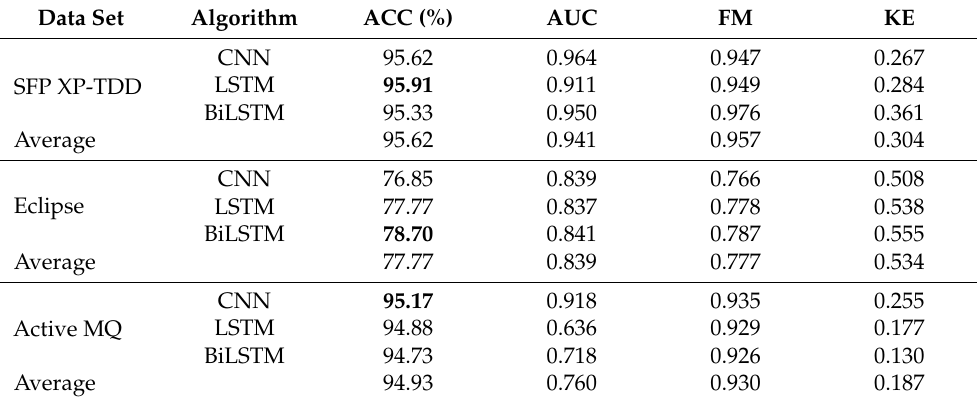
Table 10. Deep Learning Algorithm Based Classification results for All Data